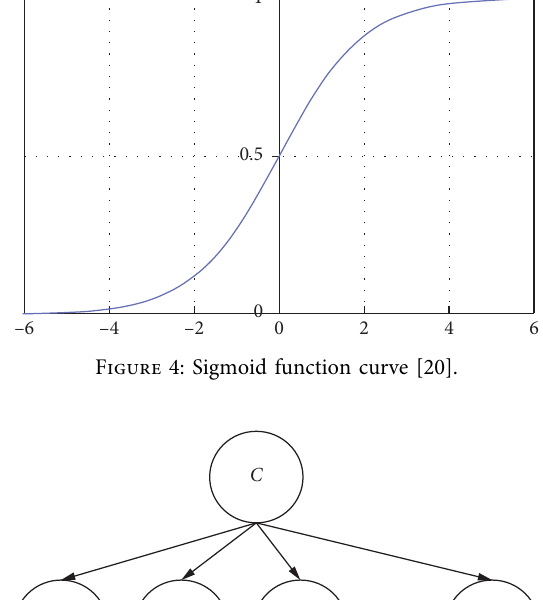
Figure 5: Na¨ıve Bayes principle